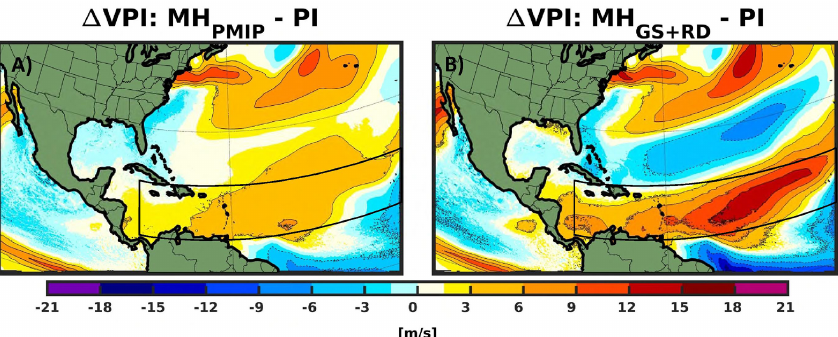
Figure 14. Changes in climatological seasonal V PI (JJASON) for the (a) MH PMIP and (b) MH GS + RD experiments relative to PI. The black box shows the present-day MDR. Only values that are significantly different at the 5% level using a local (grid-point) t test are shaded. The contour lines follow the color-bar scale (dashed, negative anomalies; solid, positive anomalies); the 0 line is omitted for